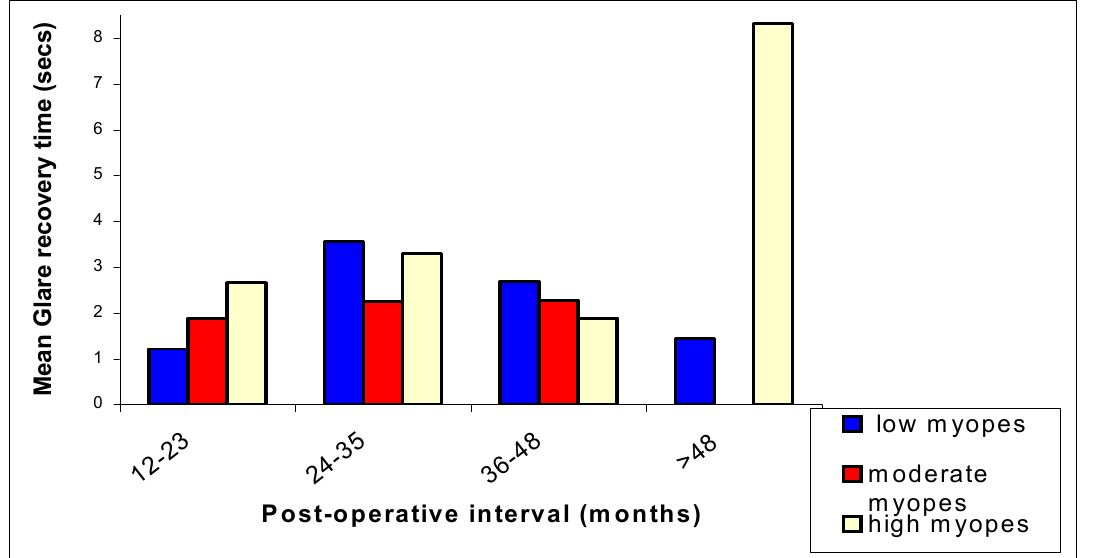
Figure 3 Mean glare recovery times according to degree of pre-operative refractive error and the post-operative interval (months